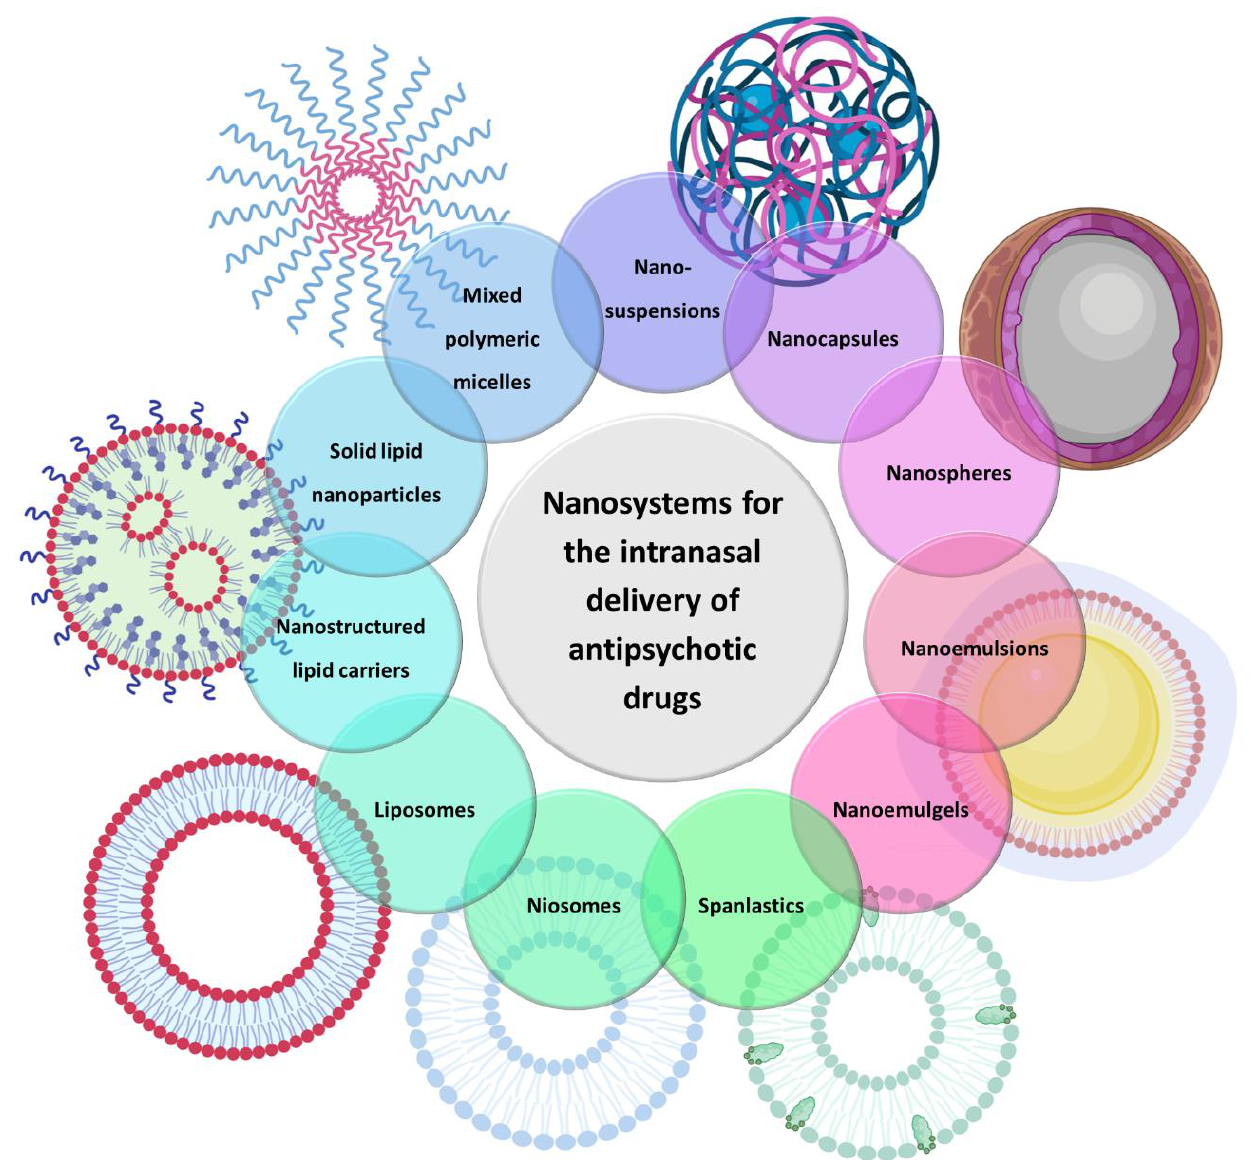
Figure 2. Types of nanosystems that have been used for the brain delivery of antipsychotic drugs.